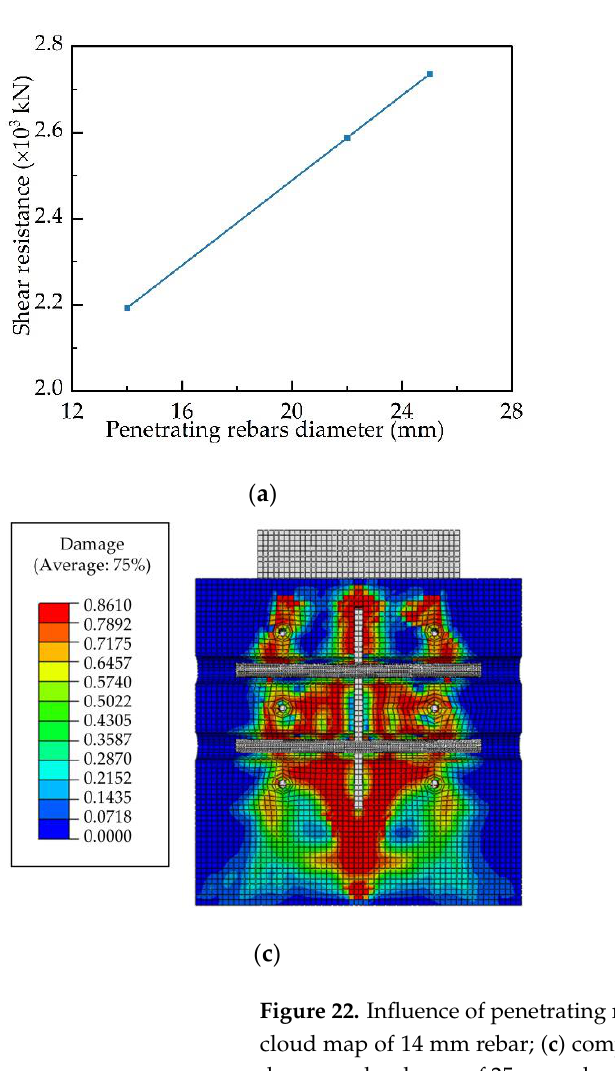
( d ) Figure 21. Influence of welded stud diameter: ( a ) shear resistance; ( b ) compressive damages cloud map of 16 mm welded stud; ( c ) compressive damages cloud map of 19 mm welded stud; ( d ) com- pressive damages cloud map of 22 mm welded stud. 4.3.3. Penetrating Rebars Diameter Finite element models were established and analysed using different diameters (14 mm, 22 mm, and 25 mm) of penetrating rebars as parameters, as demonstrated in Figure 22a. Increasing the penetrating rebars ’ diameter significantly increases the composite con- nectors ’ shear resistance. This is due to two main reasons. On the one hand, the shear resistance of the penetrating rebars is increasing significantly. On the other hand, the con- crete in the hole is in triaxial compression under the combined action of the penetrating rebars, the perforated steel plate, and the surrounding concrete. This increases the com-